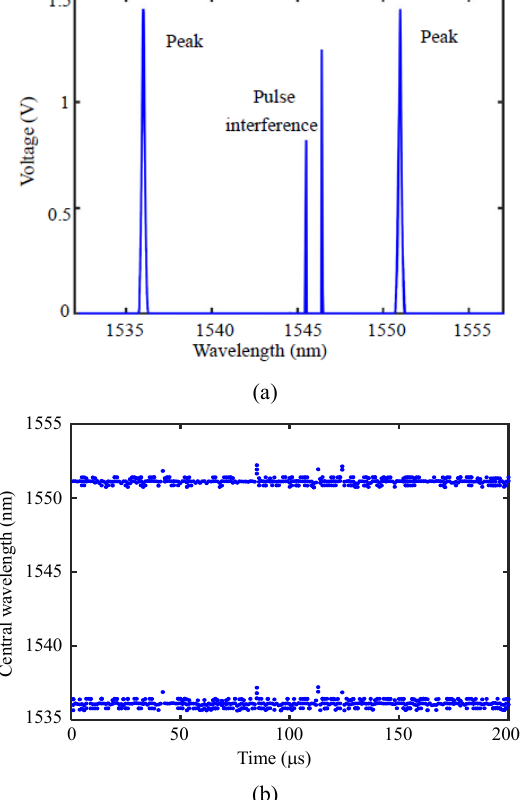
Fig. 4 Reflection spectrum of FBG and the results of interrogation: (a) the reflection spectrum of FBG and (b) the results of